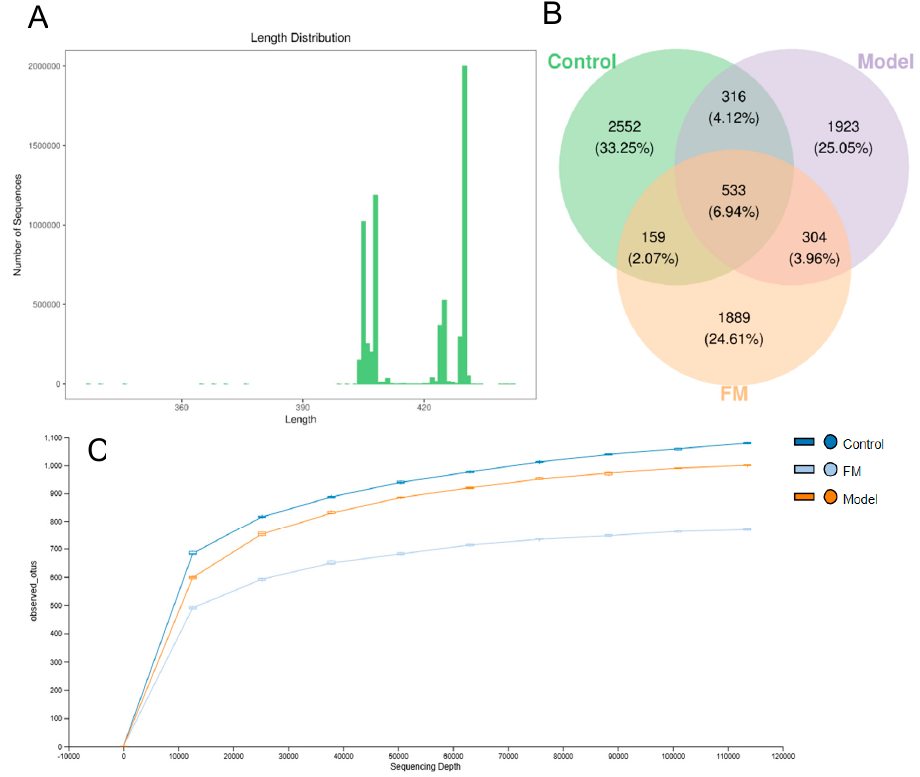
Figure 6. Sequence number and length of samples ( A ), Venn diagram for describing the common and unique OTUs ( B ) and rarefaction curve of OTUs of samples ( C ).